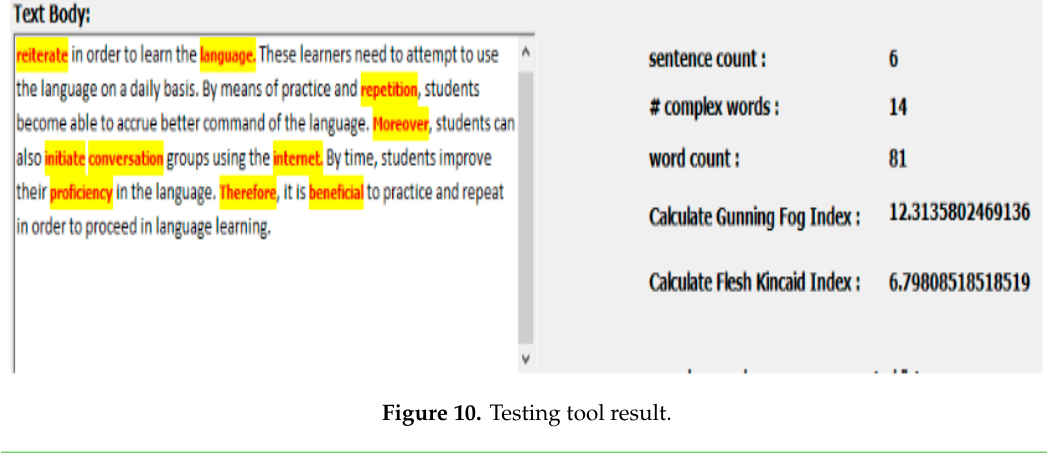
Figure 10. Testing tool result.